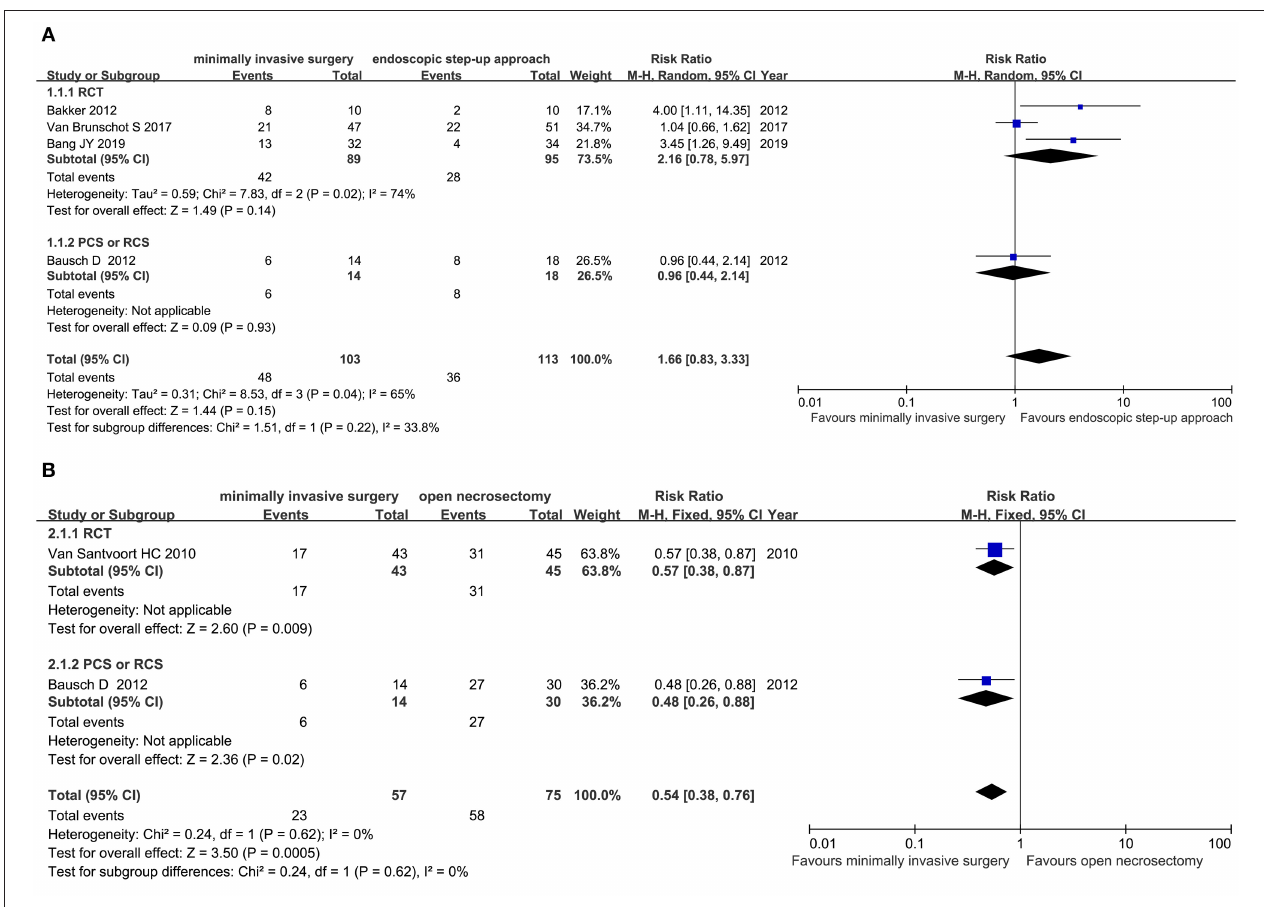
FIGURE 3 | Forest plots for the major complications or death rates. (A) Between minimally invasive surgery and endoscopic step-up approach. (B) Between minimally invasive surgery and open necrosectomy. M-H, Mantel–Haenszel test; Random, a random effects model; CI, confidence intervals.